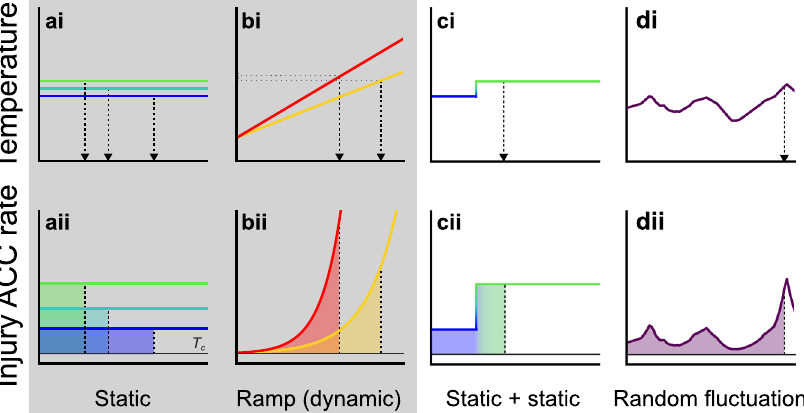
Figure 2. Temperature profiles of heat tolerance experiments and their corresponding temperature-dependent injury accumulation (ACC) rates based on parameters from the thermal death time curve. x-axes represent a time scale. Shaded areas under the curves represent identical amounts of accumulated injury that result in heat failure (lethal dose, Aii – Dii ). The exposure duration resulting in accumulation of the lethal dose is reported as t coma (static) or CT max (dynamic), marked by vertical and horizontal arrows, respectively, in Ai-Di. The grey box highlights the two classical assay types (static and dynamic). Note that injury only accumulates at temperatures above a specific critical temperature (T c , thin black line). ( Ai – Aii ) Exposure to a static temperature yields a constant temperature-dependent injury accumulation rate. ( Bi – Bii ) Exposure to a dynamic ramp where temperature changes by a fixed rate resulting in an exponentially increasing injury accumulation rate with time. The fast ramping rate (red) results in a shorter exposure before CT max is observed than the slow rate (yellow), but as the injury accumulation rate increases more slowly for the low ramping rate, the final CT max is lower. ( Ci – Cii ) During initial exposure to a static temperature (blue), some injury is accumulated, but not sufficient to trigger coma onset. Successive exposure to another static temperature (green) produces the critical amount of injury, but as some injury had already accumulated, the exposure to the second temperature is shorter than if